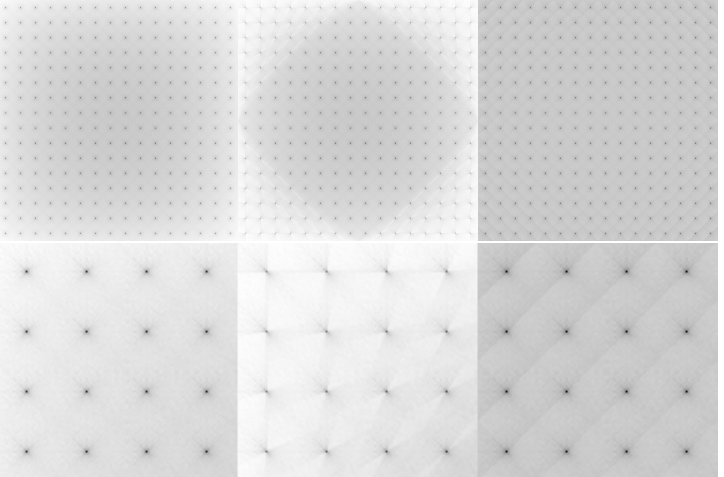
Figure 17. Top row, from left to right, the respective adjoint operators applied to the conventional, central, and periodic forward DRTs of an input, constituted by 16 × 16 equispaced black pixels. Bottom row, details of top left corners of back-projections in the same